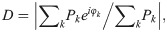
Nonlinear subunits and directional processing.A-C: Tests for nonlinear summation within the receptive field. The stimulus was a 400 μm-diameter spot centered on the receptive field, filled with a stripe grating that contrast-reversed every 1 s. For stripes of width 200 μm or less, a stripe boundary passed through the spot center. A: A sample RGC fires a burst of spikes on every grating transition unless the stripe width drops below a threshold, here 25 μm. B: Peak firing rate as a function of stripe width, normalized to the response to the uniform spot (400 μm); mean ± SEM across cells of each type. C: Threshold stripe width, an estimate of subunit size; mean ± SEM across cells of each type (n = 22, 23, 8, 20 left to right in panels B and C). All alpha types except Off-s show nonlinear summation over subunits ~30 μm in size. D-E: Tests of direction selectivity. D: Firing of a sample RGC in response to a 250 μm diameter spot of the preferred polarity moving through the receptive field center at 700 μm/s in 8 directions spaced at 45° (different colors). E: Direction selectivity index computed from such responses as
D=|∑kPkeiφk/∑kPk|,
where φk is the direction of motion of the k-th stimulus, and Pk is the peak firing rate evoked by that stimulus. Mean ± SEM across cells of each type (n = 3, 3, 7, 3 left to right).